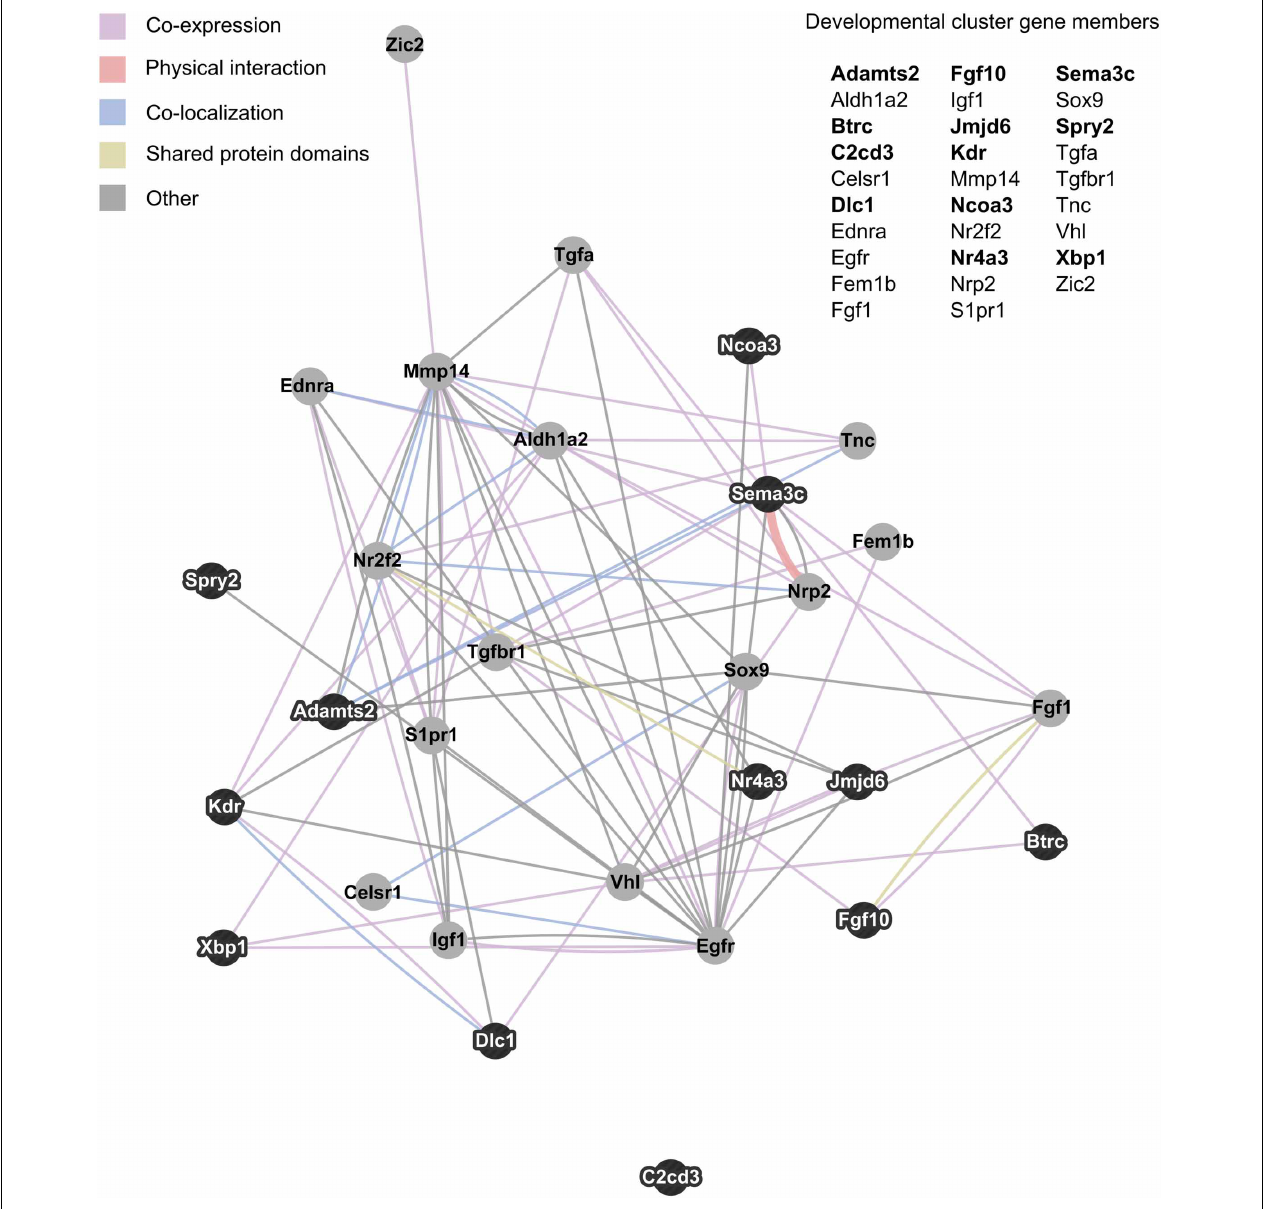
FIGURE 3 | Interaction network of developmentally related genes with altered expression in maternal mPFC. The 29 genes that appeared in two or more developmental clusters recognized by NIH’s DAVID functional annotation clustering as enriched within significant maternal mPFC expression results were visualized as an interaction network in GeneMania. Gene symbols in bold text are upregulated in lactating